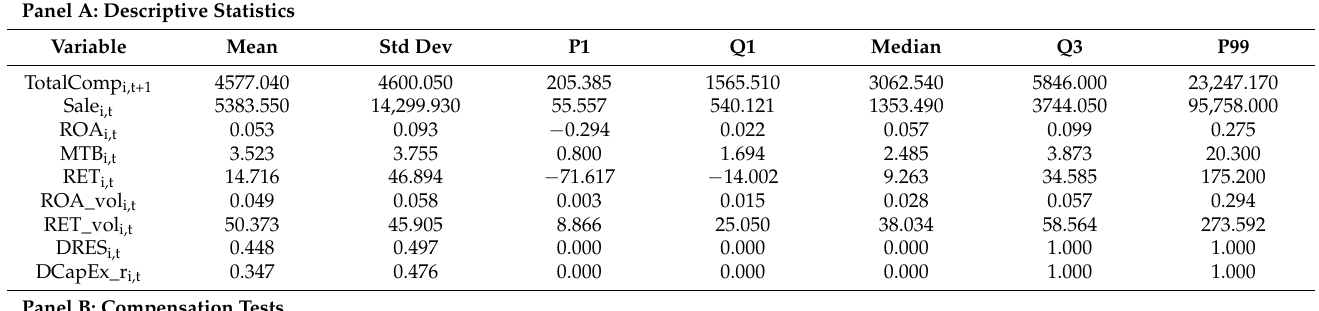
Table 10. Tests of the Association between Leases and Executive